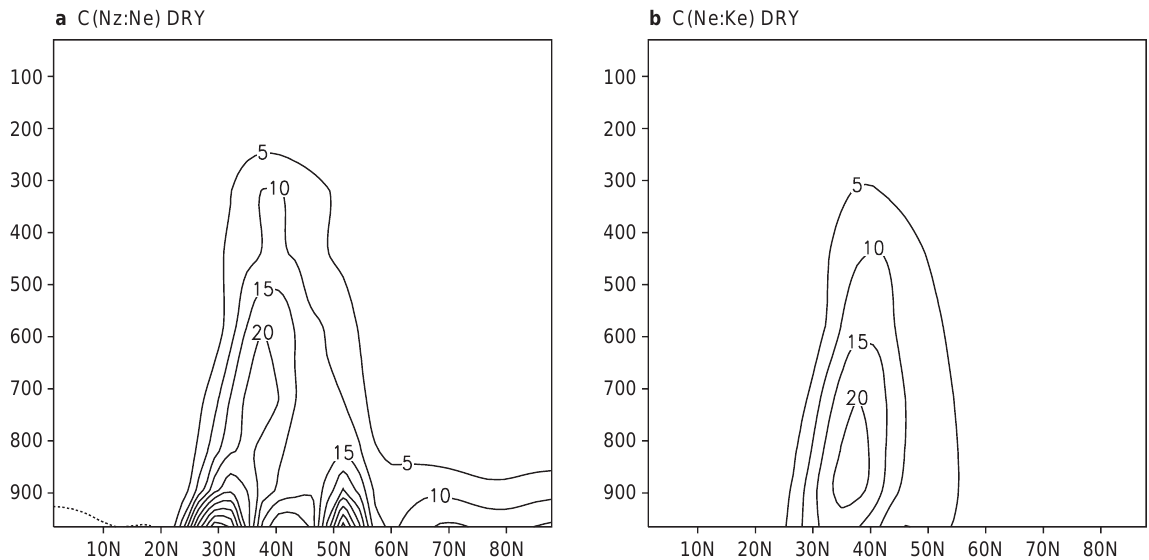
Fig. 8a,b. The average spatial distribution over days 8 to 10 of the integrand of the conversion from a N z to N e and b N e to K e for the DRY life cycle. Contours every 5 (cid:2) 10 5 J m (cid:255) 2 per day